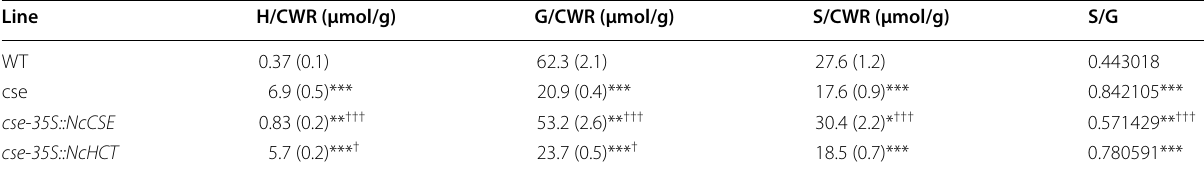
The data outside and inside the brackets are mean value and SEM (n * Significant difference compared with WT, † indicates significant difference compared with cse (* and † 0.01 < p<0.05), (** and †† 0.001 < p < 0.01), (*** and ††† p < 0.001)